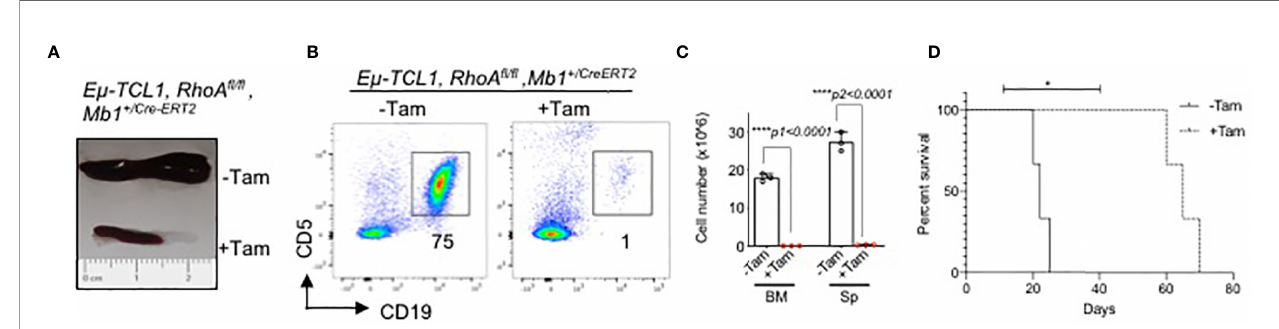
FIGURE 9 | Rapid elimination of CLL B cells after inducible deletion of RhoA . (A) Representative picture of spleen size of diseased mice treated with or without Tamoxifen. (B) Flow cytometric analysis showing elimination of CLL B cells (CD19 + CD5 low ) after 3 weeks of tamoxifen induction. (C) Absolute number of splenic CLL B cells. N=3 mice per group, unpaired t-test, two-tailed. (D) Kaplan-Meier survival curve showing the survival of Eµ-TCL1 RhoA fl / fl Mb1 +/CreERT2 mice after Tamoxifen-induced RhoA deletion (+Tam) or without treatment (-Tam). Results from 3 individual mice are indicated (n=3). The P-value was determined by Mantel- Cox log-rank test (*p <